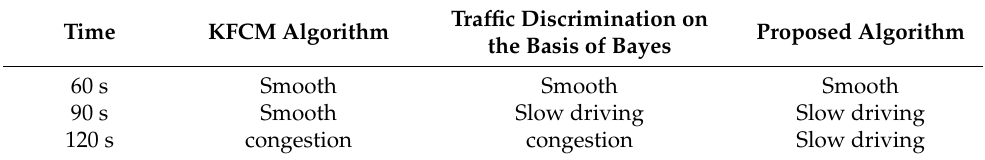
Table 7. Congestion discrimination by different